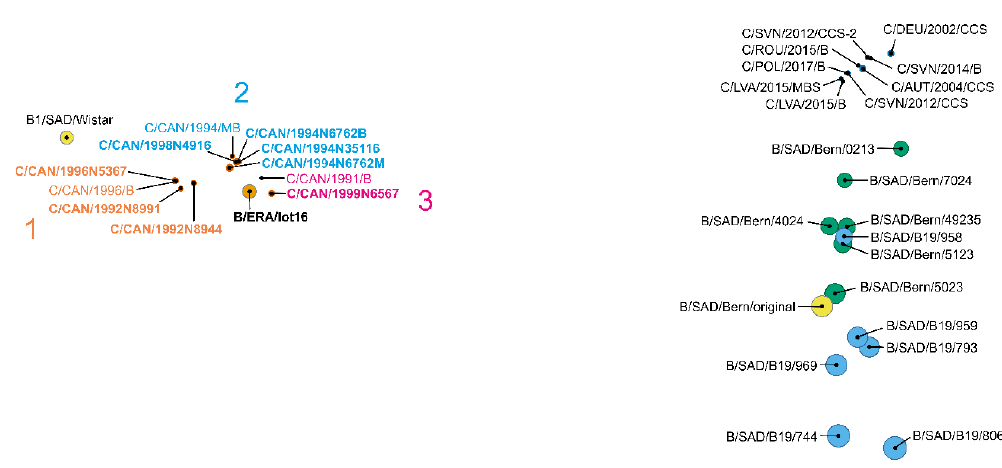
Figure 1. Population-based analysis of ERA-BHK21 ( left ) and SAD Bern orig -derived vaccine batches (B / ... ) ( right ) and viruses of their vaccine-induced rabies cases (C / ... ) displayed by a fitted pairwise Manhattan distances plot. Data sets of samples that were added in this study (Tables 1 and 2) are highlighted in bold, whereas data sets of vaccine batches and their related induced rabies cases are displayed in di ff erent colors: blue—SAD B19 vaccine batches; green—SAD Bern vaccine batches, dark blue—SAD Bern orig -derived vaccine-induced rabies cases; orange—ERA-BHK21 vaccine batch; and dark orange—ERA-derived vaccine-induced rabies cases (orange / dark orange). For the ERA vaccine-induced rabies cases, three distinct combinations of single nucleotide variants were selected that originate from the progenitor ERA-BHK21 vaccine (see Section 3.2), forming groups of samples with specific di ff erences that are represented by the colors of the respective sample names (1–3).